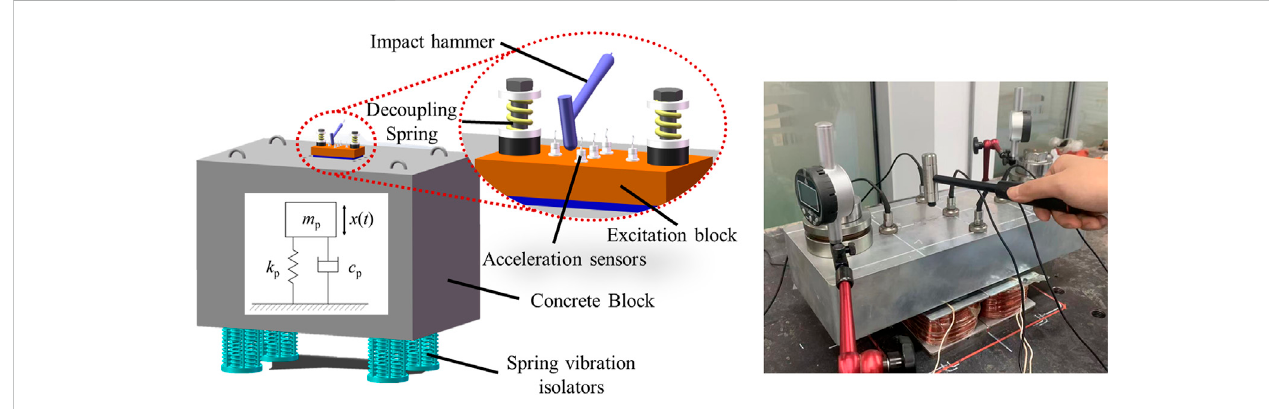
FIGURE 9 The experimental setup for characterizing the damping properties MRE railway pad with magnetic controlling unit.